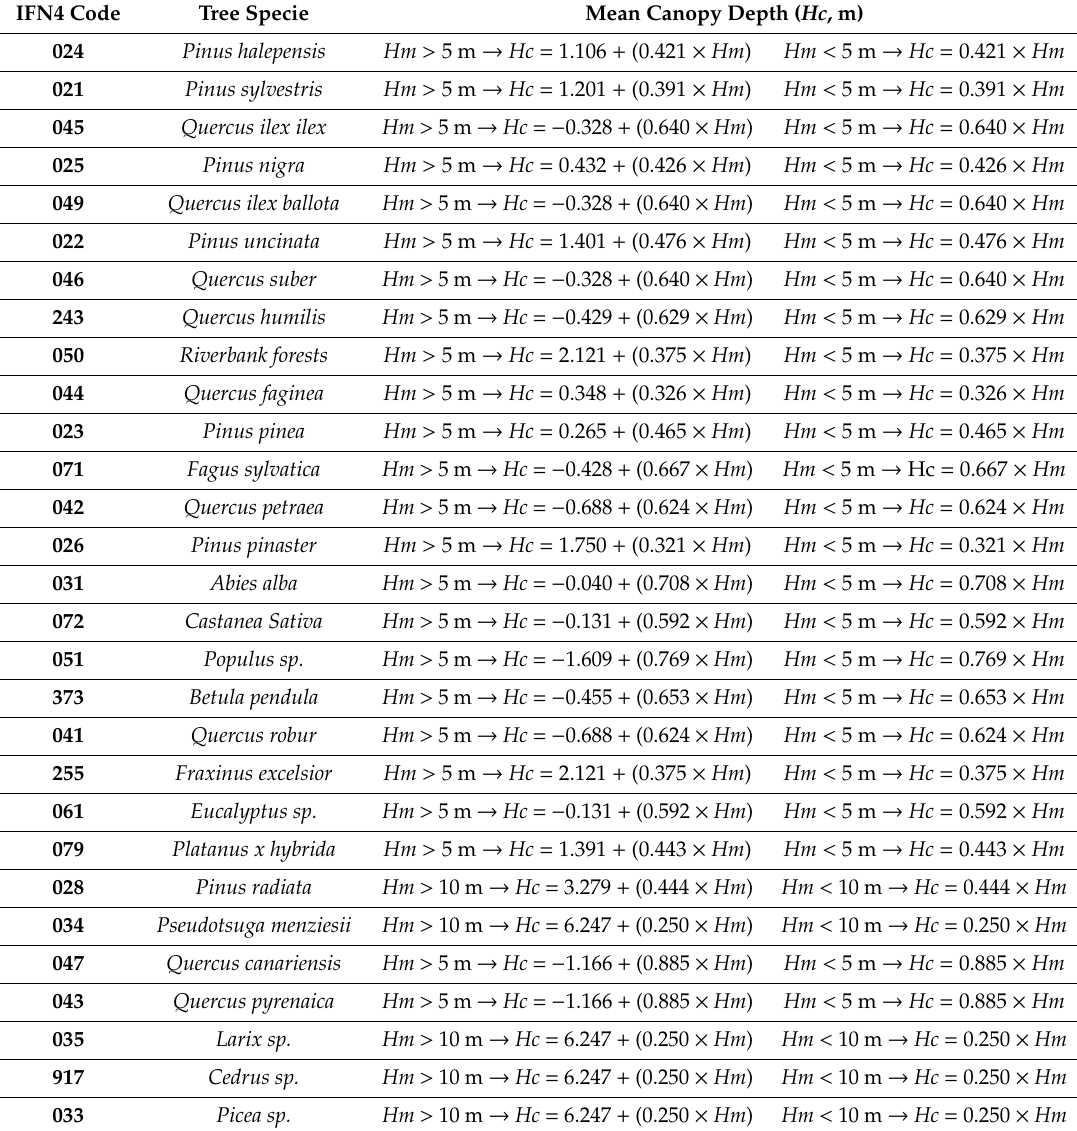
Table A1. Equations for Mean Canopy Depth ( Hc ) calculation for each species in the study